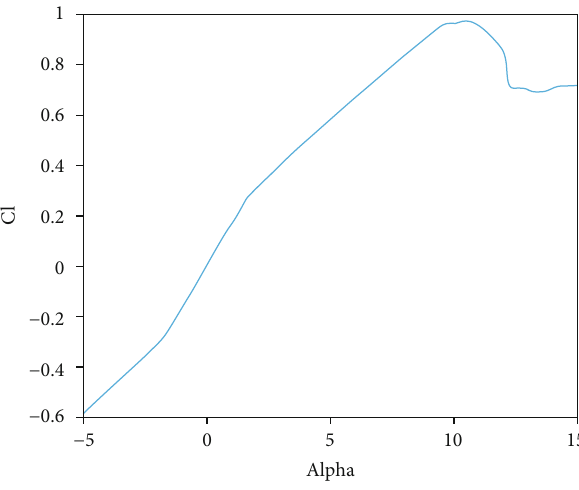
Table 3: Conceptual design data for elevator. Figure 7: Lifting coe ffi cient of the pro fi le